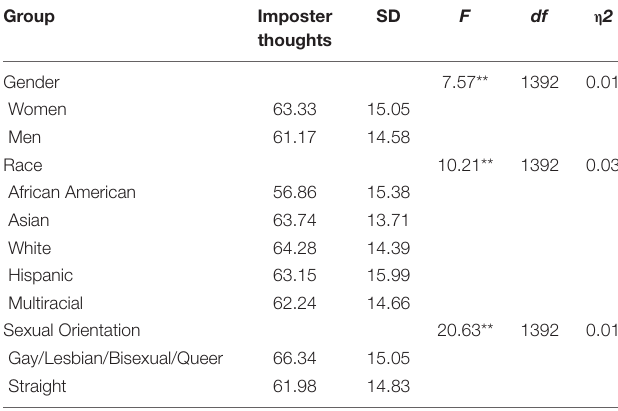
TABLE 3 | The prevalence of imposter thoughts in different groups.